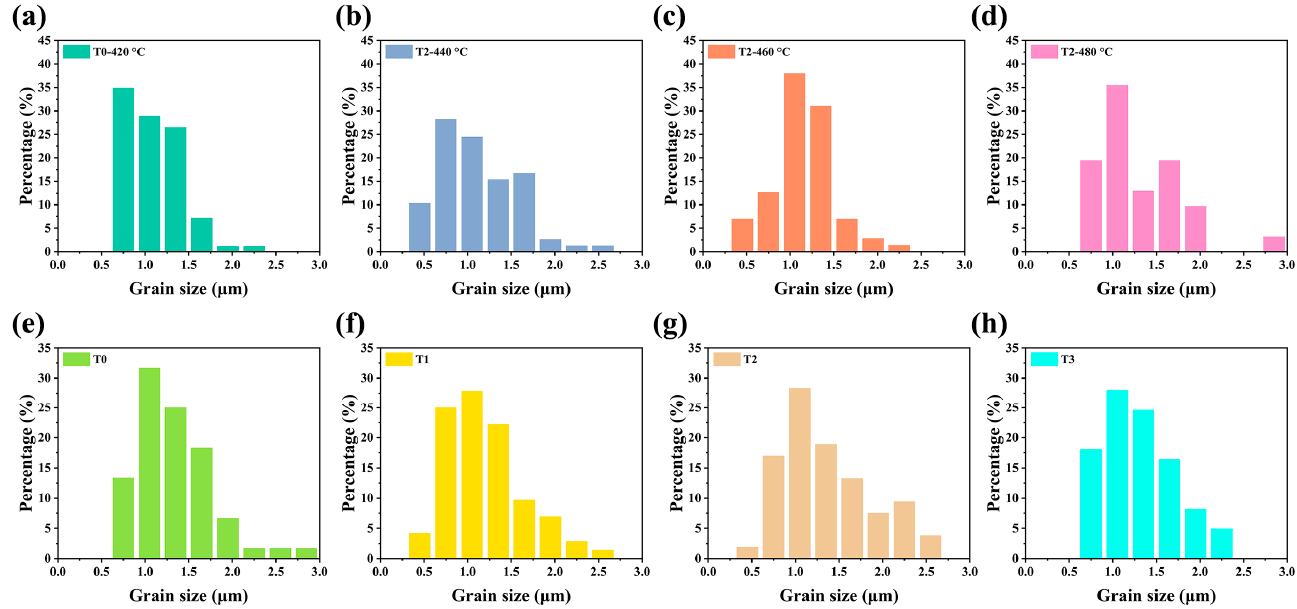
Figure 3. The particle size distribution versus the fi ne frequency histograms of the pristine Sb 2 Se 3 and Te-Sb 2 Se 3 thin fi lms under di ff erent selenization temperatures are denoted as ( a ) T0-420 °C, ( b ) T2-440 °C, ( c ) T2-460 °C, and ( d ) T2-480 °C, respectively. ( e – h ) The particle size distribution versus the fi ne frequency histograms of the pristine Sb 2 Se 3 and Te-Sb 2 Se 3 thin fi lms under the di ff erent weights of the Te source, labeled as ( e ) T0, ( f ) T1, ( g ) T2, and ( h ) T3, respectively.